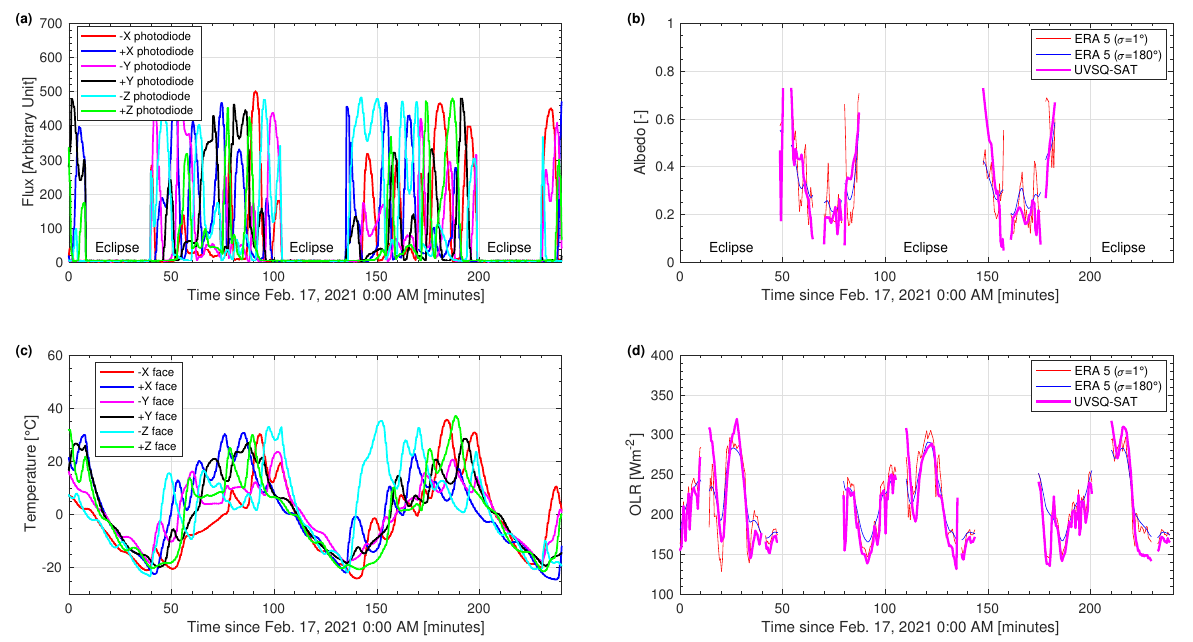
Figure 12. ( a ) Evolution of the measured flux by the six photodiodes during a given period. ( b ) Evolution of the albedo modeled from the ERA5 data and for UVSQ-SAT observations. ( c ) Evolution of the satellite temperatures. ( d ) Evolution of the